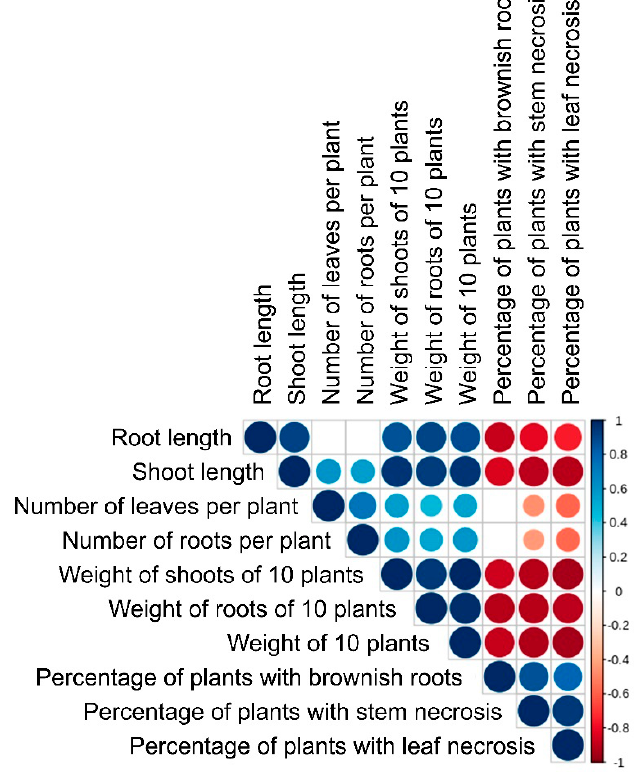
Figure 13. The correlation analysis of different parameters of plants infected by the isolated Microdochium nivale strains. The size of a circle and its color corresponds to the value of correlation coefficient. Blue circles—positive correlation; red circles—negative correlation. The scale bar is given to the right. Critical values for Pearson’s correlation coefficient r = 0.433.